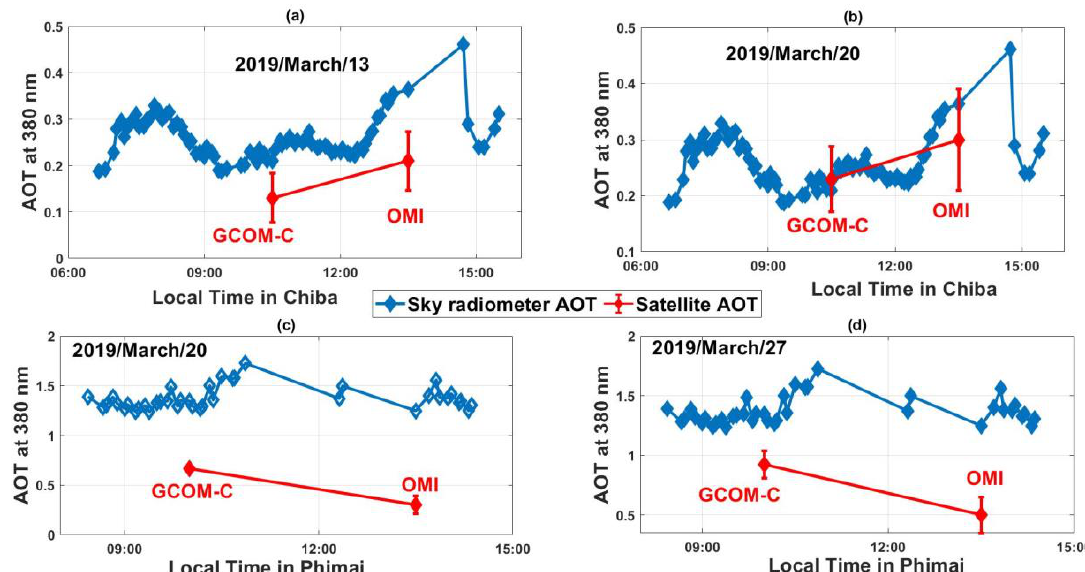
Figure 9. (top panel) The diurnal variation in the AOT at 380 inferred from the sky radiometer and combination of GCOM-C and ozone monitoring instrument (OMI) AOT values in Chiba on ( a ) 13 March and ( b ) 20 March. The sky radiometer data within 20 min of GCOM-C (10:20 LT) and OMI (13:30) overpass time were used. The coincidence criterion for both satellite dataset was within 20 km of the Chiba site. (bottom panel) The diurnal variation in AOT at 380 nm observed from the sky radiometer and combined satellite (GCOM-C plus OMI) observations in Phimai on ( c ) 20 March and ( d ) 27 March. The data selection criterion for the sky radiometer and satellites was similar to that for Chiba. The error bars in ( a ), ( b ), ( c ), and ( d ) indicate the 1σ standard deviation.